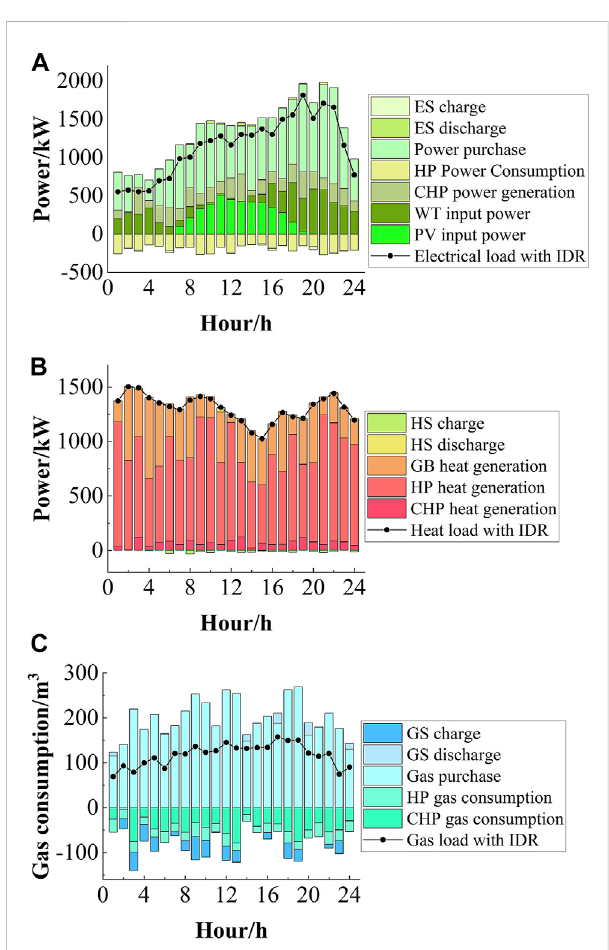
FIGURE 4 The power balance for scenario 5: (A) Electric Power Balance of the IES; (B) Heat Power Balance of the IES; (C) Gas Consumption Balance of the